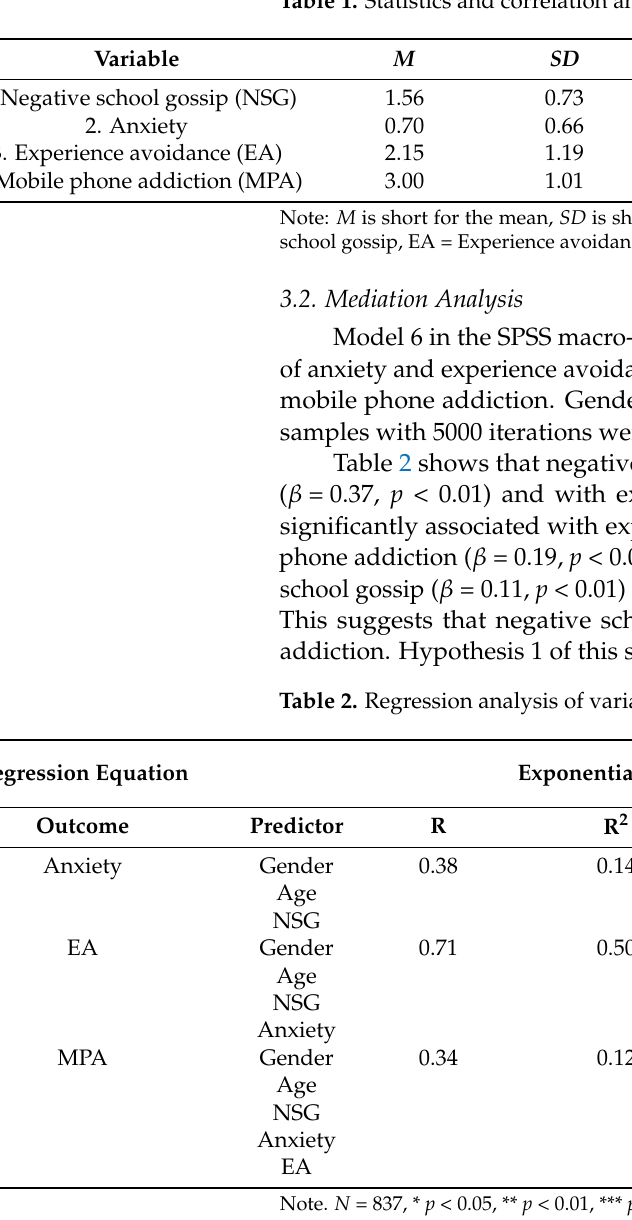
Table 1. Statistics and correlation analysis between variables.